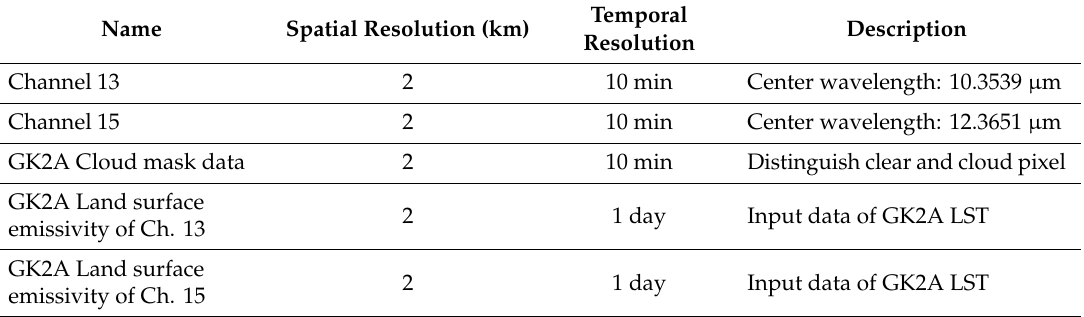
Table 1. The characteristics of GK2A / AMI data used in this